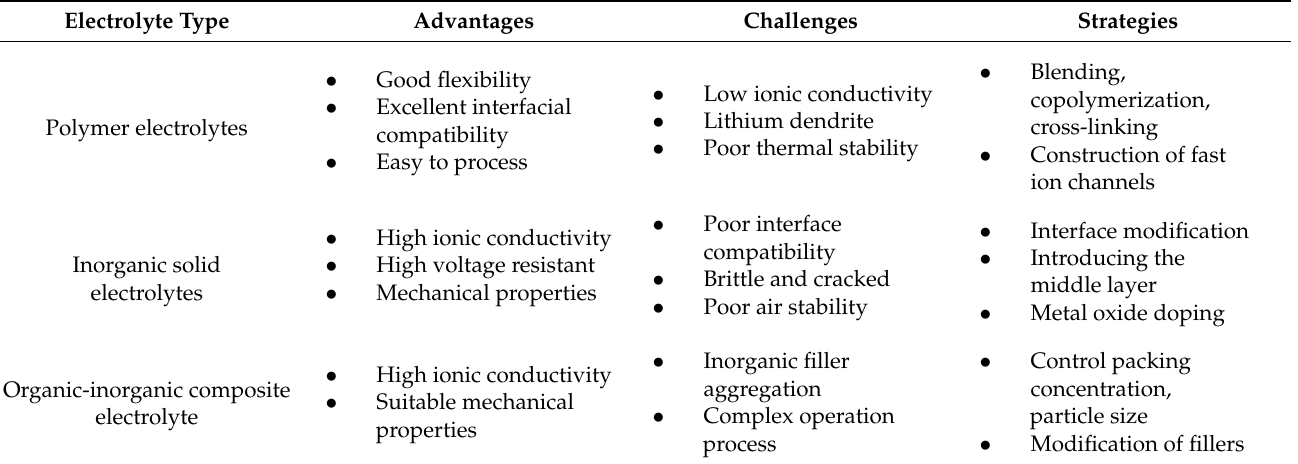
Table 2. Advantages, challenges and common solutions of